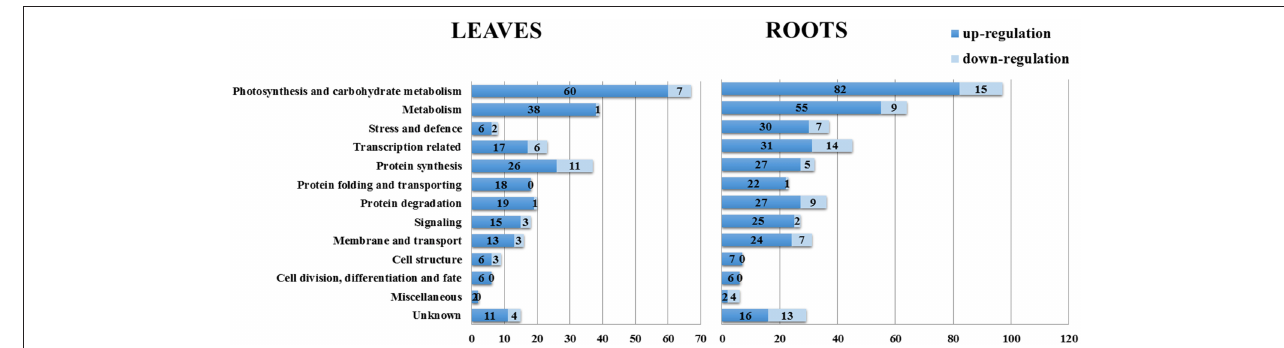
FIGURE 4 | Distribution of NaCl-responsive proteins in different functional categories. The plot showed numbers of up-regulation and down-regulation proteins in each functional category in soybean leaves and roots under salt treatment.